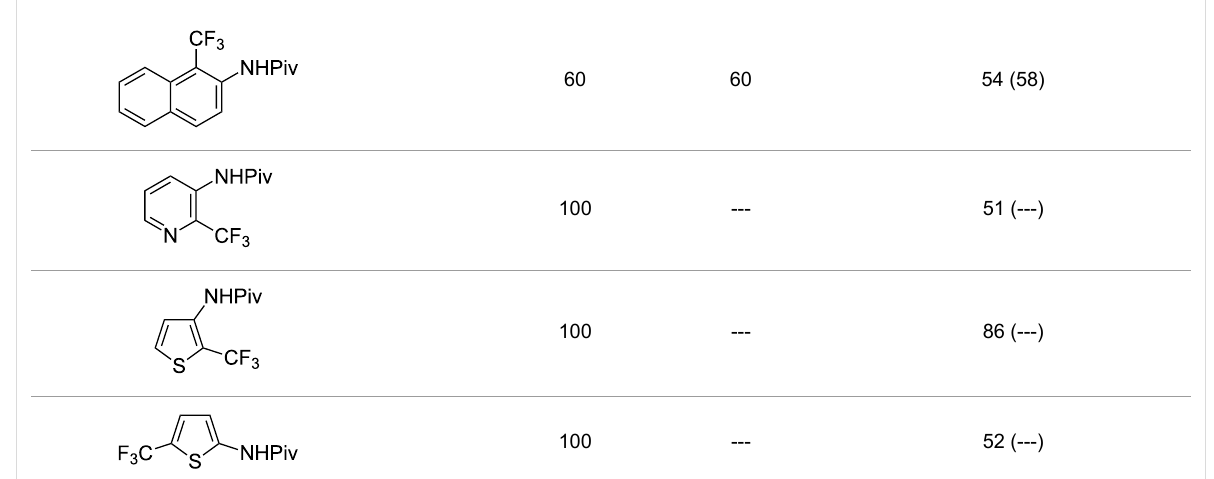
Table 17: Cu-catalyzed C–H functionalization of pivanilides [84]. (continued)